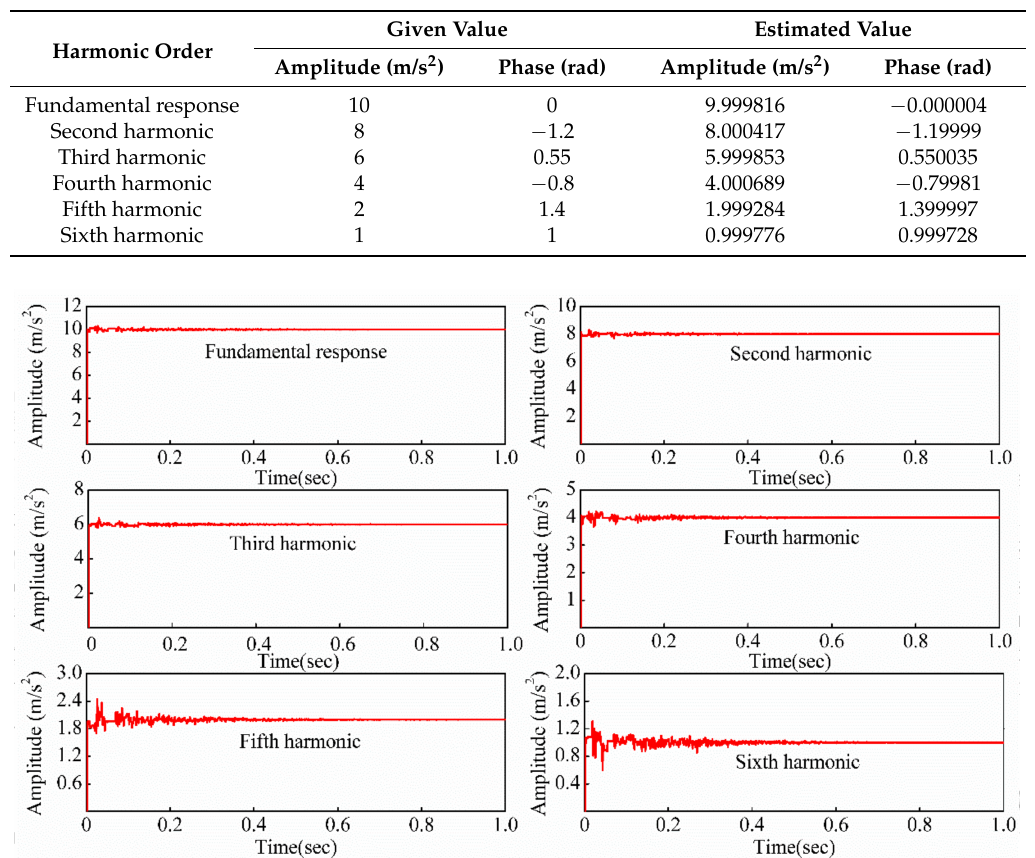
Figure 6. Estimation of